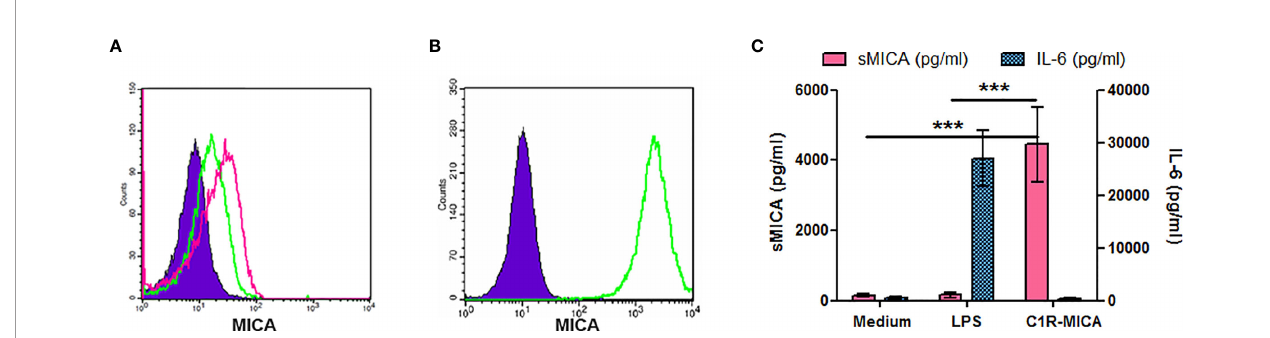
FIGURE 6 | Only extreme plasma membrane MICA expression leads to sMICA release. Cells were cultured for 15 hours and MICA expression was analyzed by fl ow cytometry (A, B) , while sMICA release as well as IL-6 secretion were estimated by ELISA (C) . (A) MICA expression by enriched monocytes, either unstimulated (green histogram) or after LPS stimulation (pink histogram). As a negative control, monocytes were stained with an isotype control instead of the MICA-speci fi c monoclonal antibody ( fi lled purple histogram). (B) MICA expression by C1R-MICA transfectants. Green histogram, MICA staining; fi lled purple histogram, isotype control staining. (C) Soluble MICA release and IL-6 secretion by monocytes cultured in medium only or supplemented with 0.5 µg/ml LPS and by C1R-MICA transfectants. Shown is one representative experiment of at least fi ve independent experiments using cells from independent donors (A, B) or data pooled from fi ve independent experiments (C, mean and SD are depicted). ***p < 0.0001 (two-tailed unpaired t -test with Welch ’ s correction, C1R-MICA transfectants versus